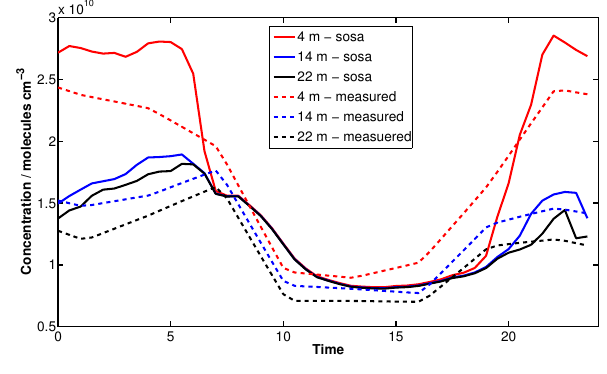
Fig. 7. Daily averaged modelled OH-reactivity as a function of al- titude for May, June, July, and August 2008. Fig. 8. Daily averaged modelled (named ’sosa’) and measured sum